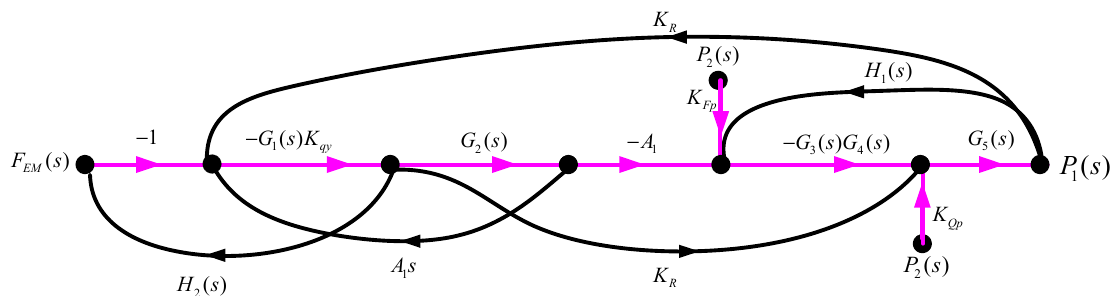
Figure 8. Signal flow diagram of proportional relief valve with the energy regeneration system.